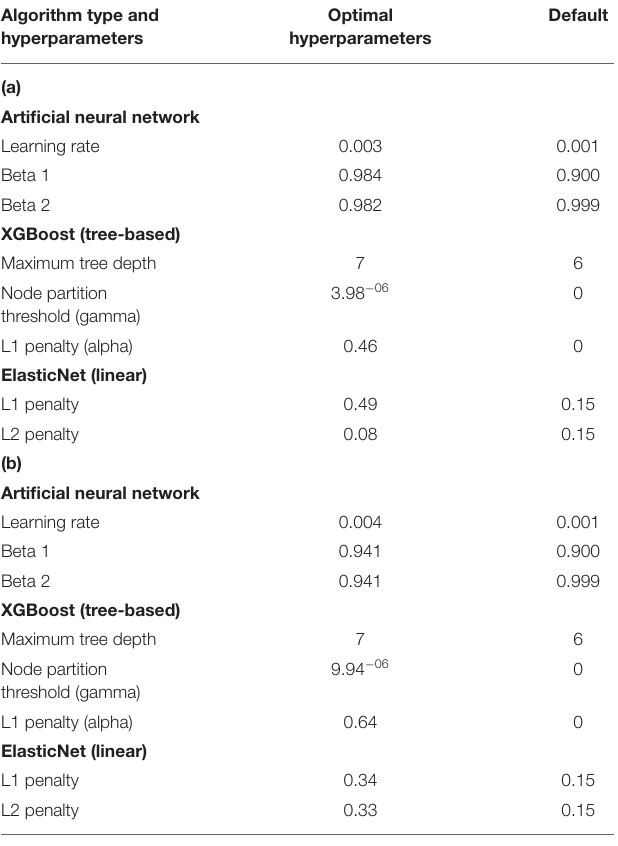
TABLE 8 | Number of generations required for fitness function to plateau during